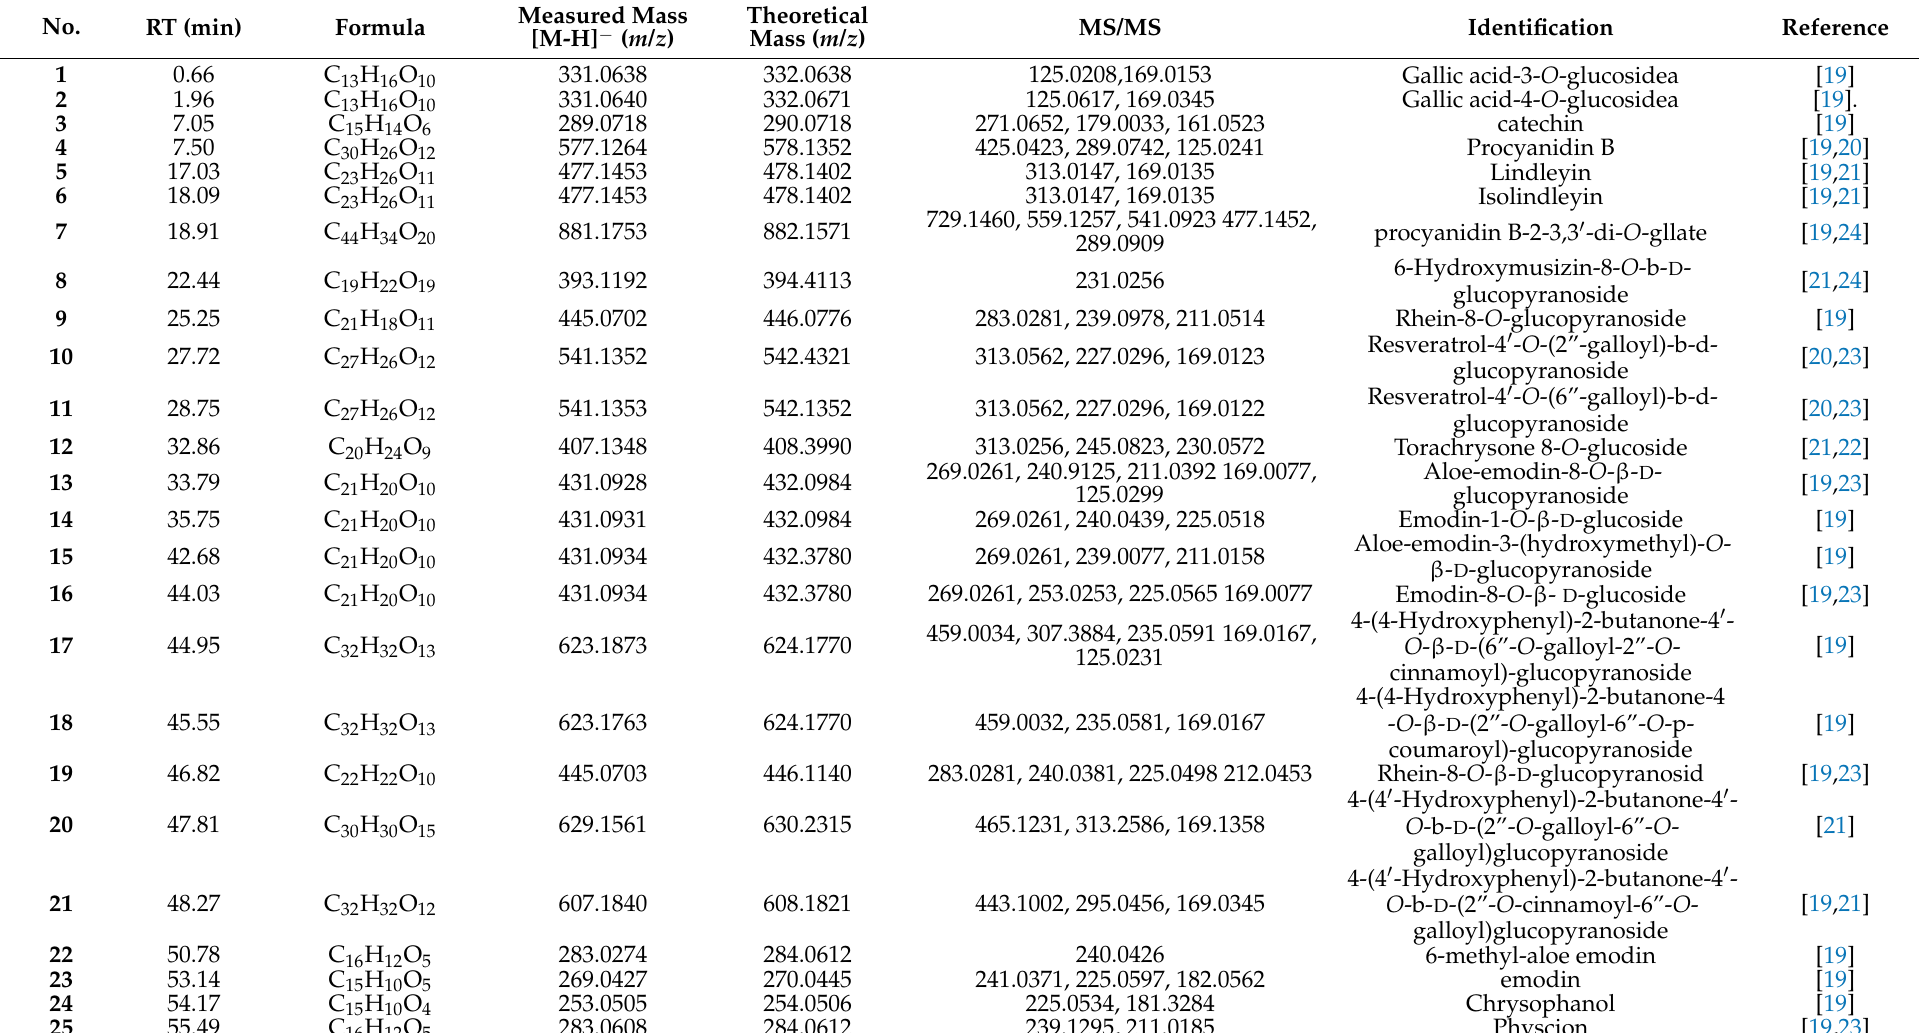
Table 1. Characterization of the bioactive constituents of RTMB by UPLC-ESI-MS detection in the negative